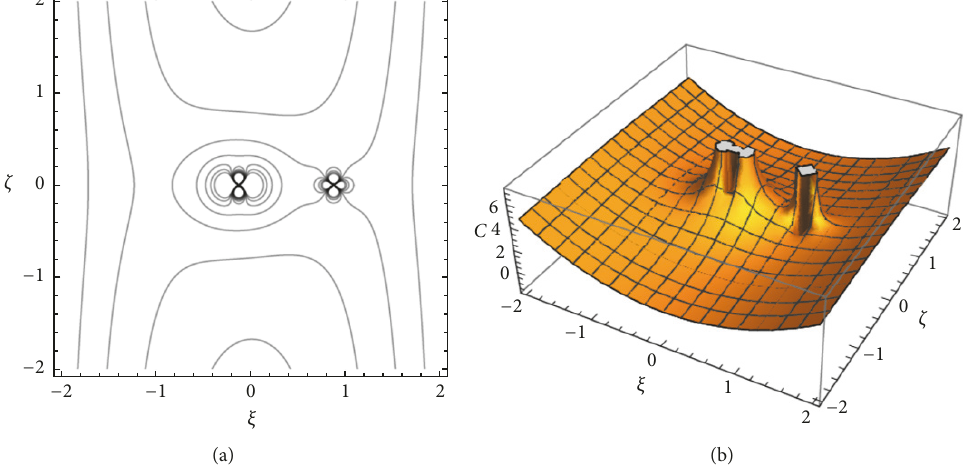
Figure 9: Zero-velocity curves in the ( 𝜉 − 𝜁 ) plane of DP-Leonis for 𝐴 = 0.02, 𝑒 = 0.1,𝑎 = 0.95, 𝜎 1 = 0.03 and 𝜎 2 = 0.015 .